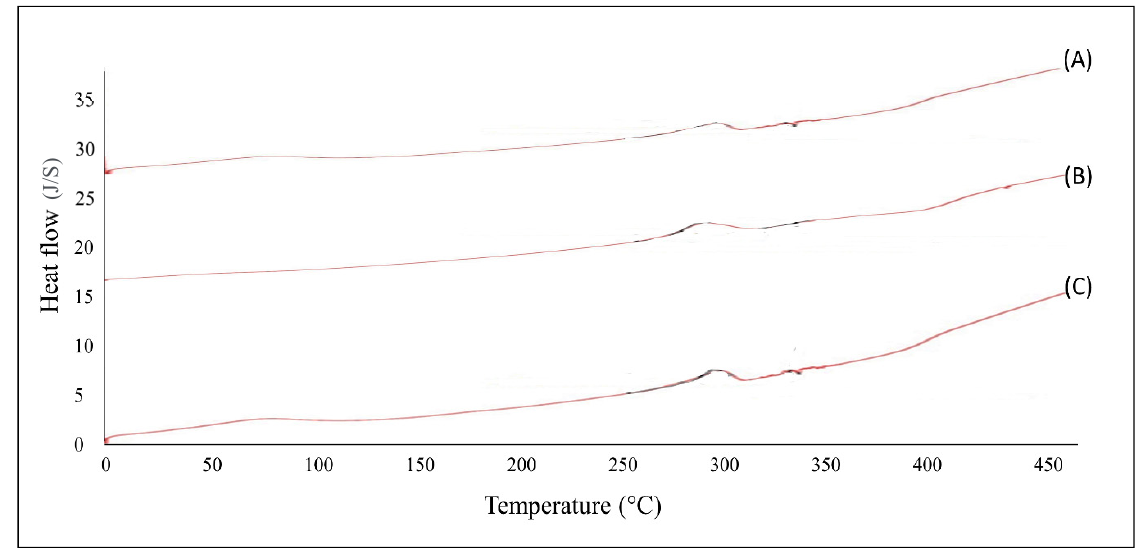
Figure 1. DSC thermograms of tizanidine with physical mixtures of chitosan and thiolated chitosan ( A ), EC and PVP ( B ), and Eudragit RL100 and PVP ( C ).